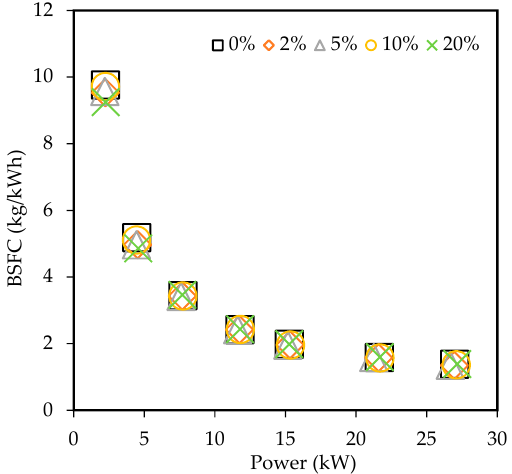
Figure 7. Variations in brake ‐ specific fuel consumption (BSFC) of tested fuel types. Energies 2020 , 13 , x